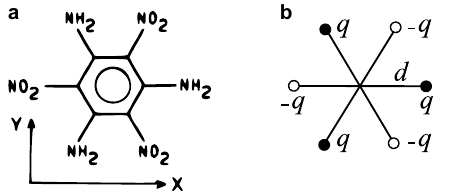
Figure 1. ( a ) An exemplary small octupolar molecule: TATB 19 and ( b ) the model six-arm